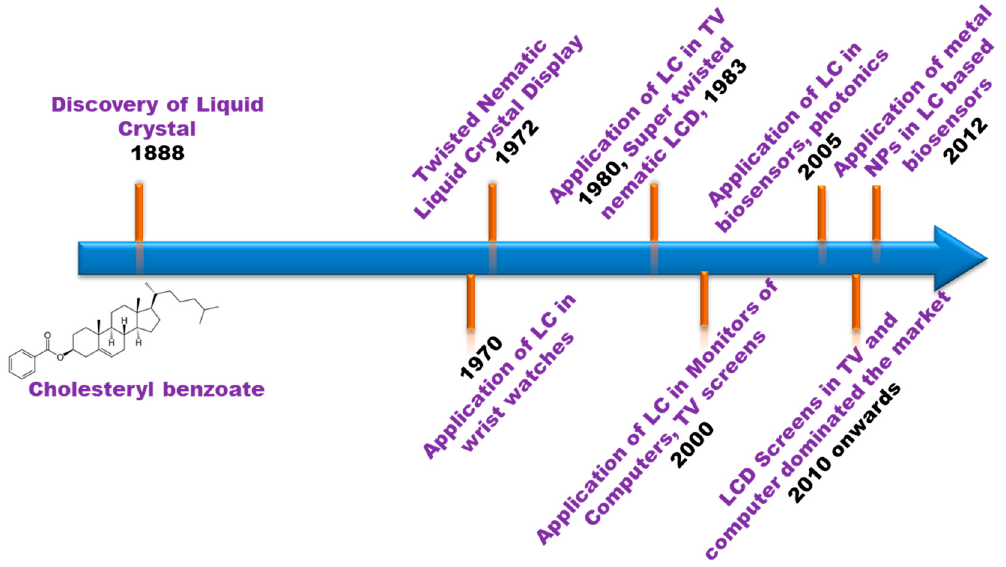
Figure 1. Schematic of significant developments in the history of liquid crystals. As indicated, the first display took around hundred years for the commercialization of LC displays (LCDs) after the discovery of liquid